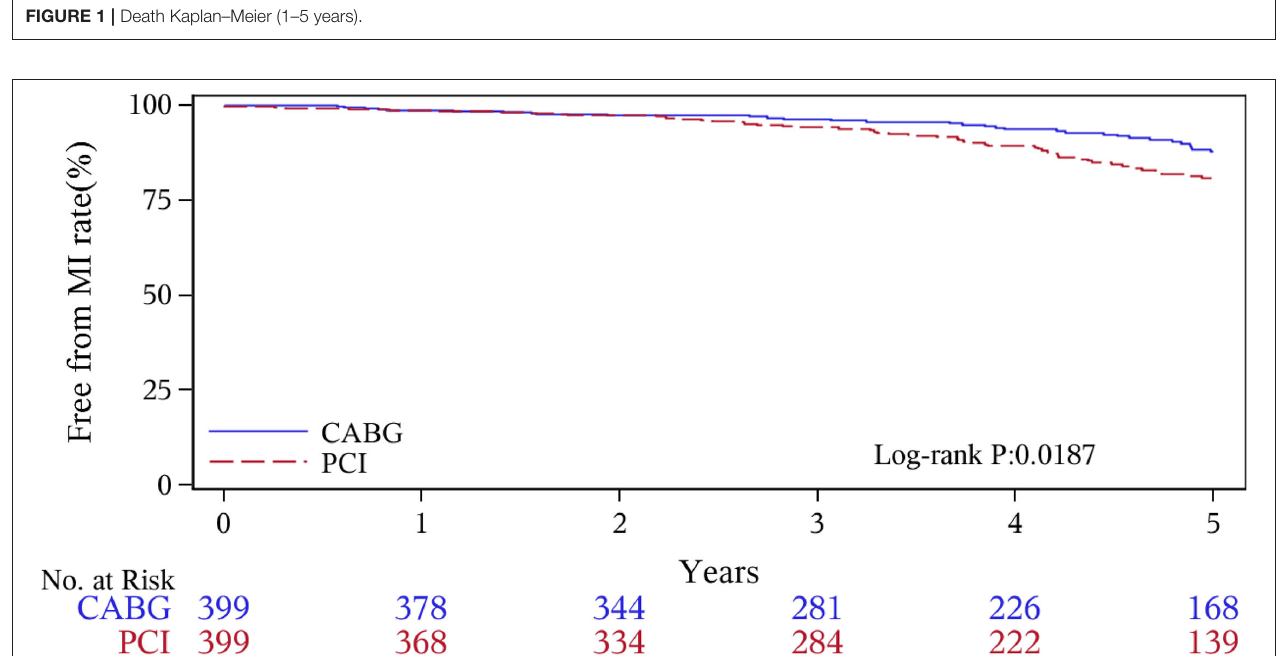
FIGURE 2 | Myocardial infarction (MI) Kaplan–Meier (1–5